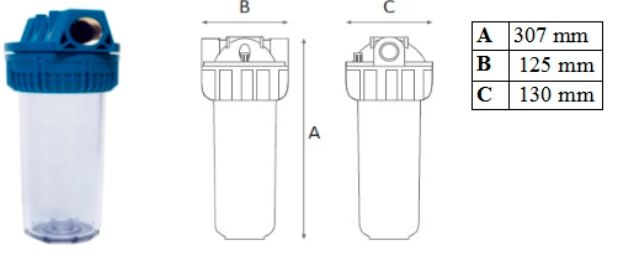
Figure 4. Container for filter cartridges.